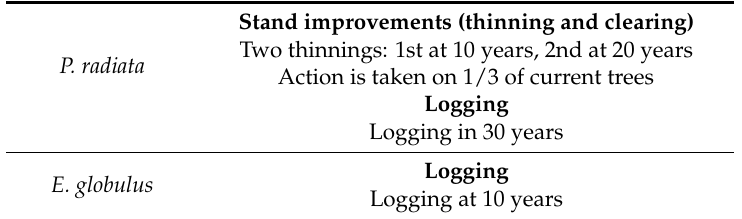
Table 3. Forest biomass generating silvicultural operations.